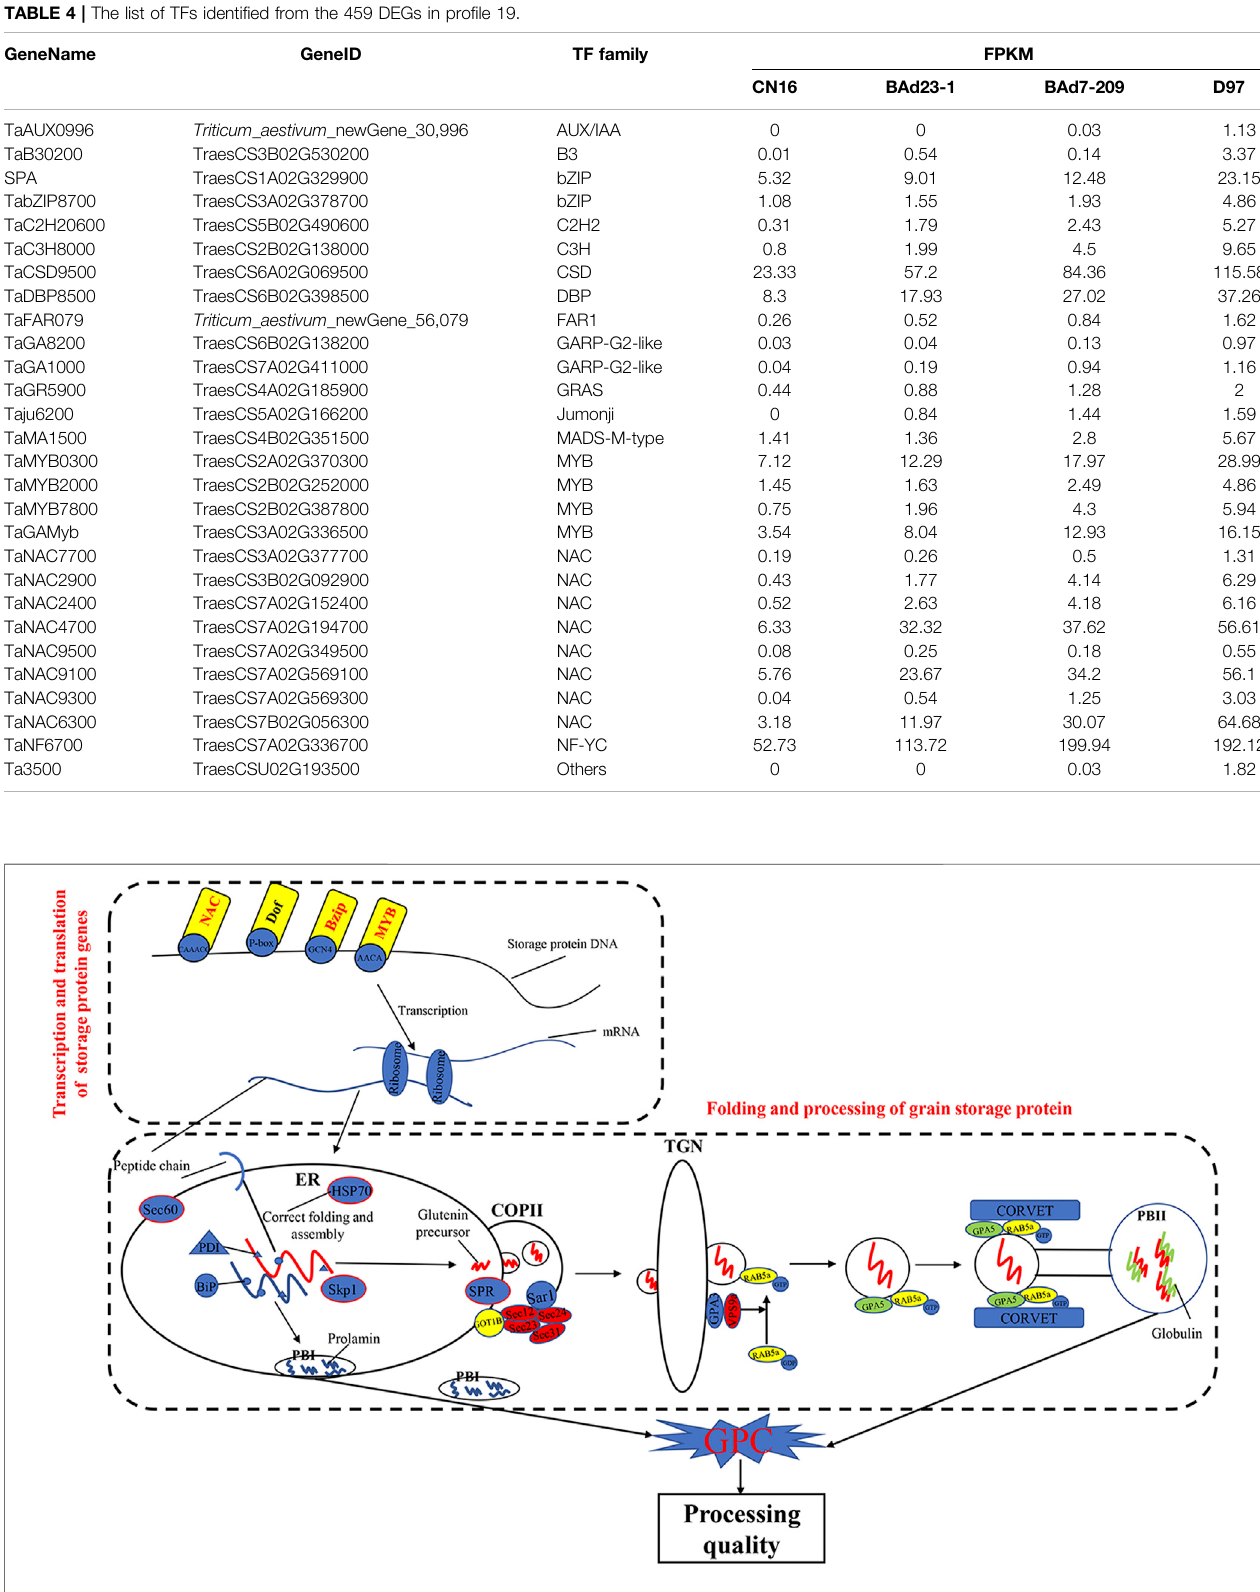
FIGURE 7 | The synthesis and regulation pathways of grain storage protein.